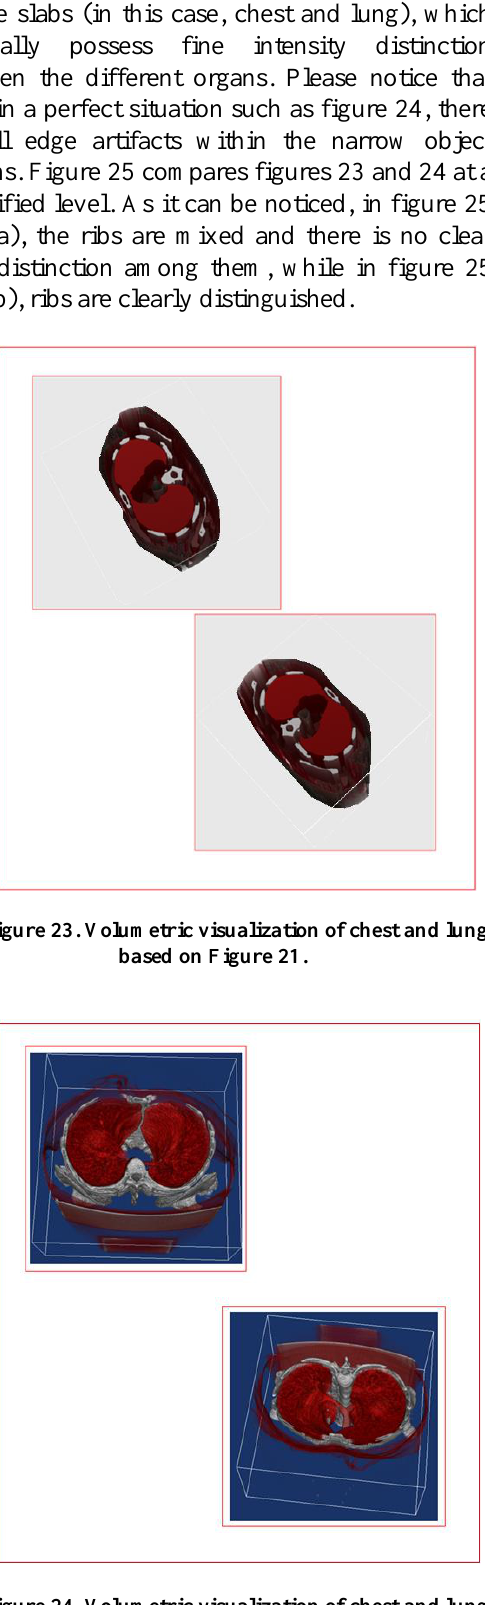
Figure 24. Volumetric visualization of chest and lung via standard ray